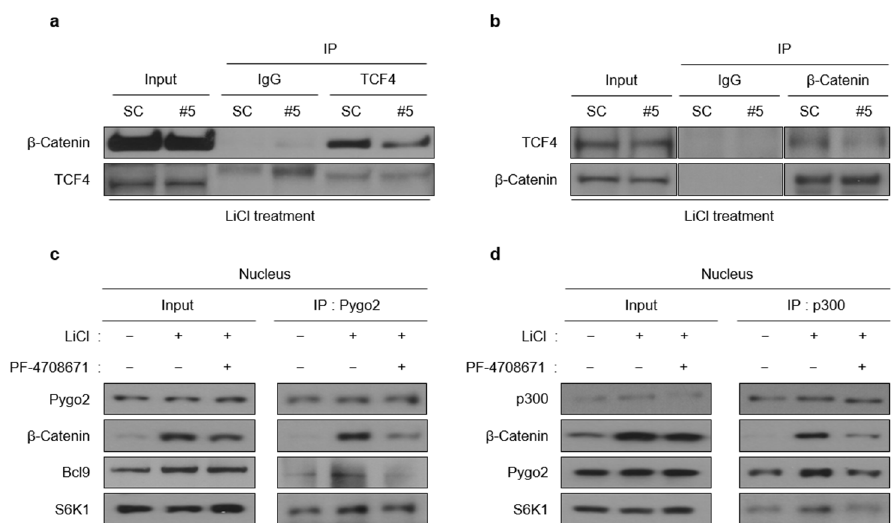
Figure 5. S6K1 affects the formation of the Wnt/ β -catenin transcriptional complex. ( a , b ) S6K1 knockdown reduces the interaction between β -catenin and TCF4. Co-immunoprecipitation assay was performed using TCF4 ( a ) and β -catenin ( b ) antibodies and 293T cells treated with LiCl (25 mM) for 8 h after transient transfection with S6K1 siRNA (48 h). ( c , d ) Inhibition of S6K1 disrupts formation of Wnt/ β -catenin transcriptional complex. Each co-immunoprecipitation assay was performed with nuclear extracts from 293T cells treated with DMSO or PF-4708671 (10 µM) followed by LiCl treatment for 8 h, using Pygo2 ( c ) and p300 ( d ) antibody, respectively.